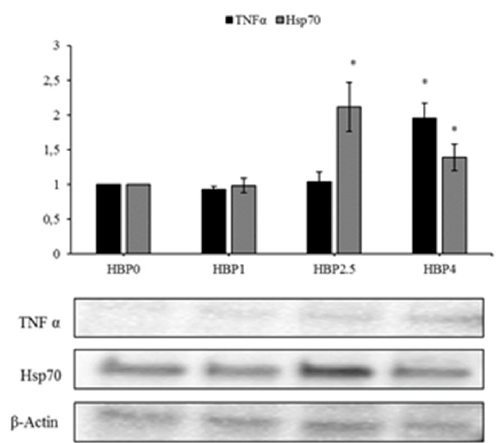
Figure 4. Immunoblot of TNF α , HSP70, evaluated on samples of the liver of A. regius fed on three di ff erent diets containing increasing levels of commercial HBP (HBP1, HHBP2.5, HBP4) and in standard condition (HBP0). β -Actin was used as the internal control. The images are representative of at least three separate experiments. The relative protein quantification is represented in the graphic (* p < 0.05 vs. HBP0).